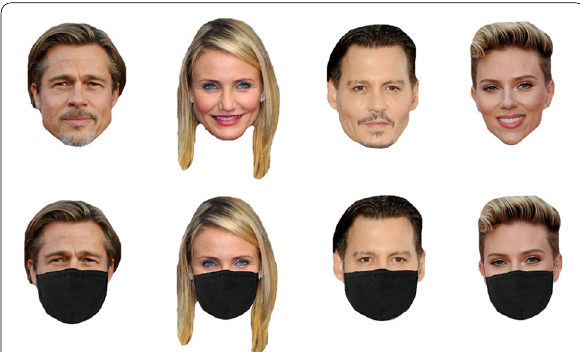
Fig. 1 Example images used in the famous face identification task. From left to right: Brad Pitt, Cameron Diaz, Johnny Deep, Scarlett